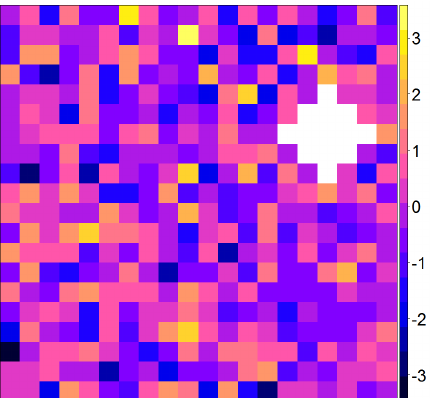
Figure 4. Simulated raster from the first scenario, wherein pixel time series are generated from the standard normal distributions, with an artificial randomly located cloud containing 13 pixels (displayed in white) in which we produce abrupt